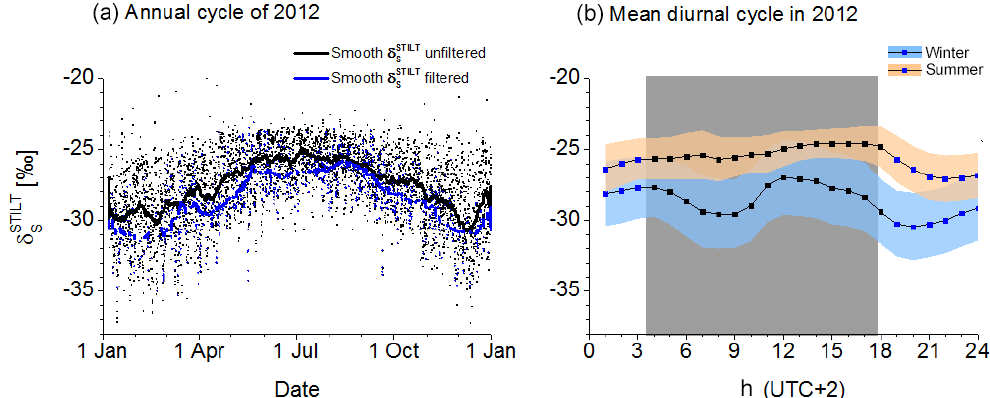
Figure 2. Source signature as calculated with the STILT model following Eq. (A1). (a) Unfiltered in black and filtered (for monotonous increase and minimal range) in blue. Only about 15% of all data points fulfill our strict criteria. However, they are distributed approximately evenly throughout the year. (b) Diurnal cycle of modeled mean source signature due to diurnally varying mean source mix. Gray areas denote times when source signature is usually filtered out.